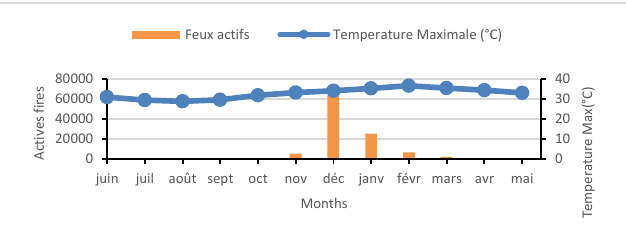
Figure 11: Interrelation between maximum temperature and number of active